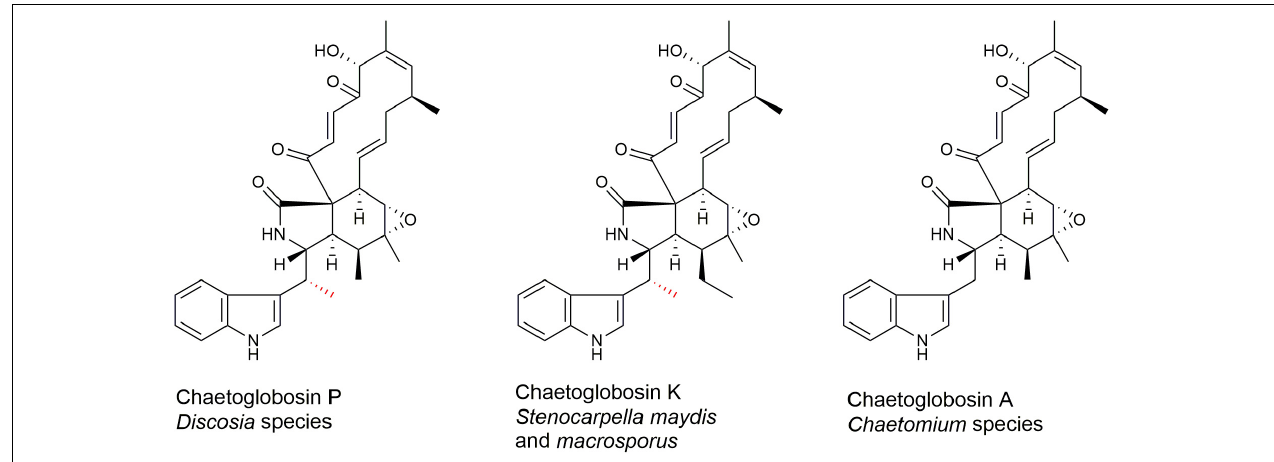
FIGURE 1 | Molecular structures of chaetoglobosins P, K, and A. The methyl substitution on C-10 of chaetoglobosins P and K is indicated in